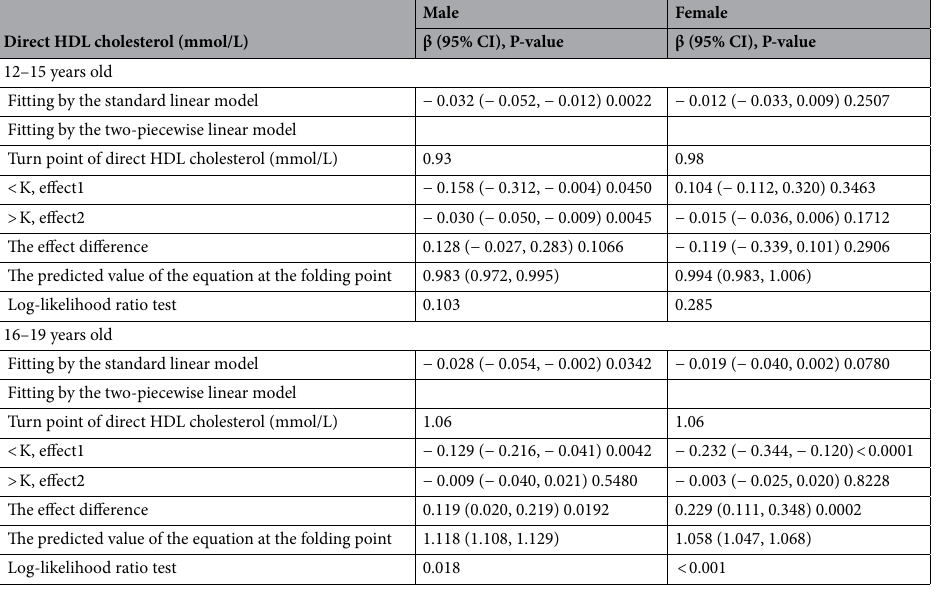
Table 4. Saturation effect analysis of high-density lipoprotein cholesterol and total bone mineral density. All covariates were